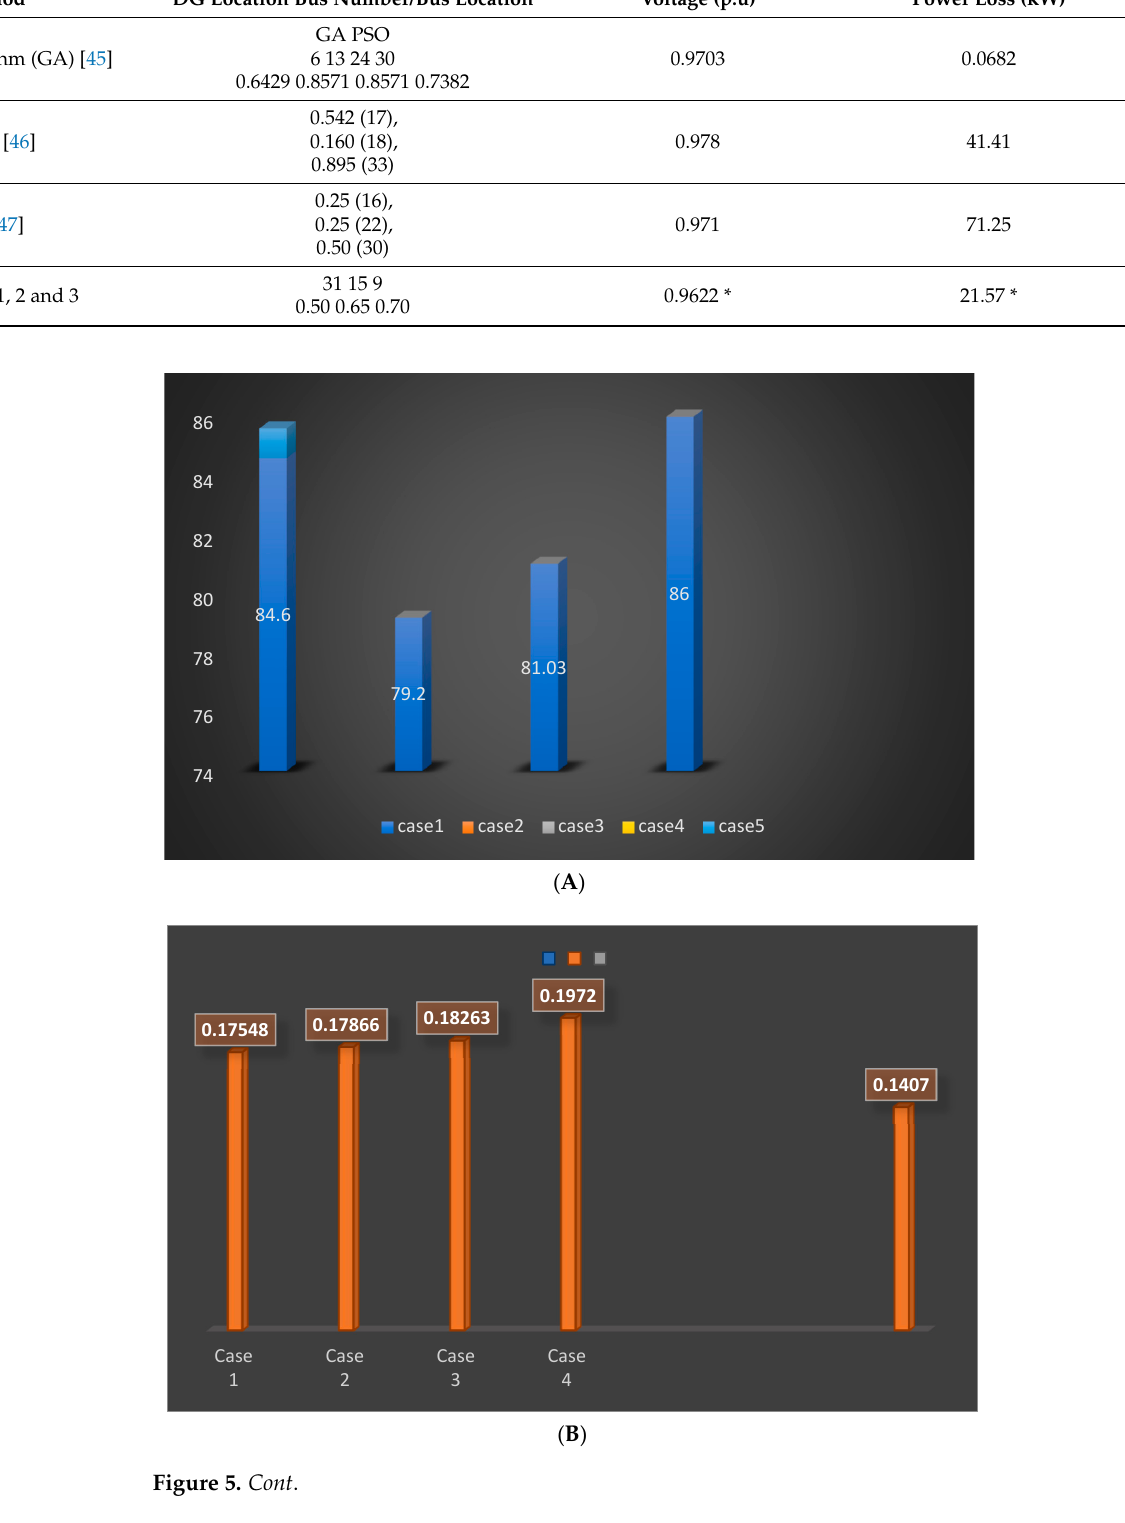
( C ) Figure 5. ( A ) Result of objective function in terms of power loss reduction with installation of DG system. ( B ) Result of voltage profile improvement with installation of DG System. ( C ) DG size, bus location and system power loss of 33-bus test system. The base case voltages for the allocation values in each bus are presented in Figure 6, the values of the voltages in (per units) are represented in the vertical axis, while the bus numbers are represented in horizontal axis. It can be observed from Figure 6.placement of hybrid renewable system based on the proposed methodology significantly reduces loses, which is expected as part of the technical objectives.